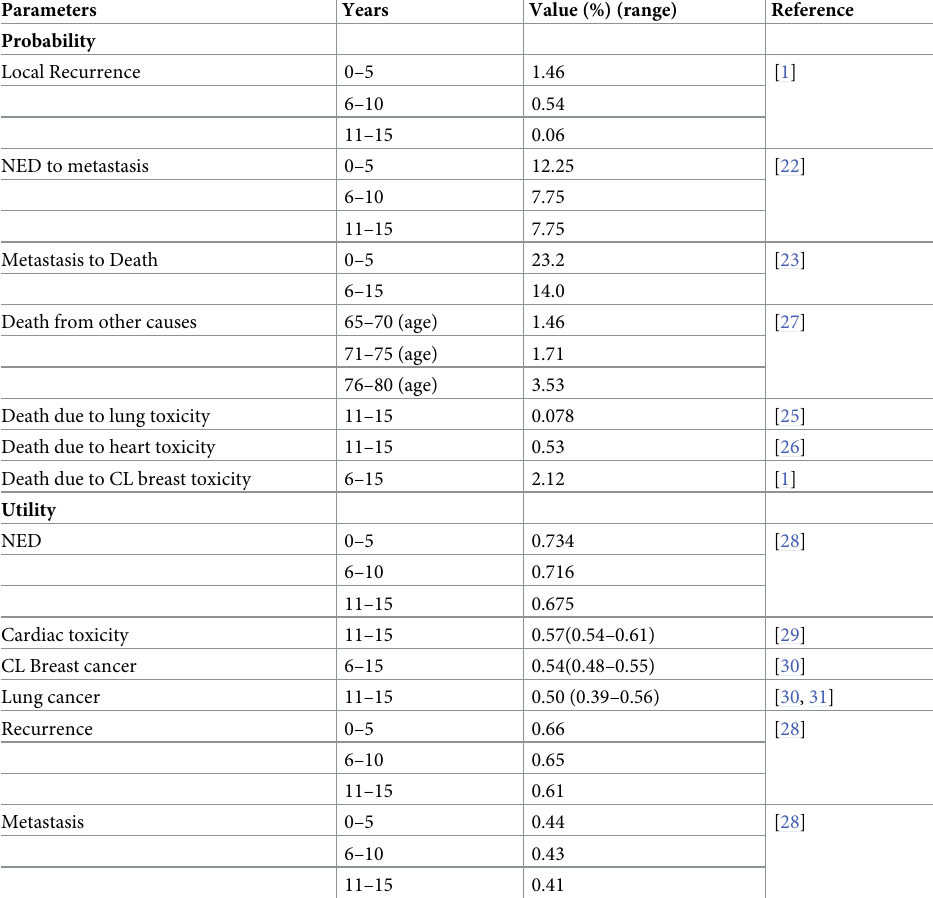
Table 1. Annual transition probability and utility for the 65-year-old patient cohort who received SOC WBRT.